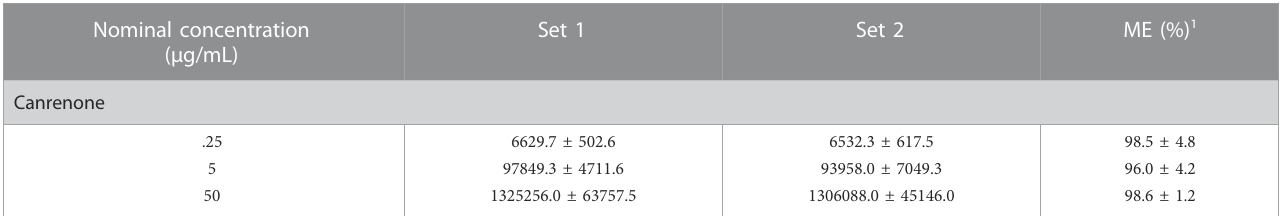
TABLE 2 Extraction recovery of canrenone.